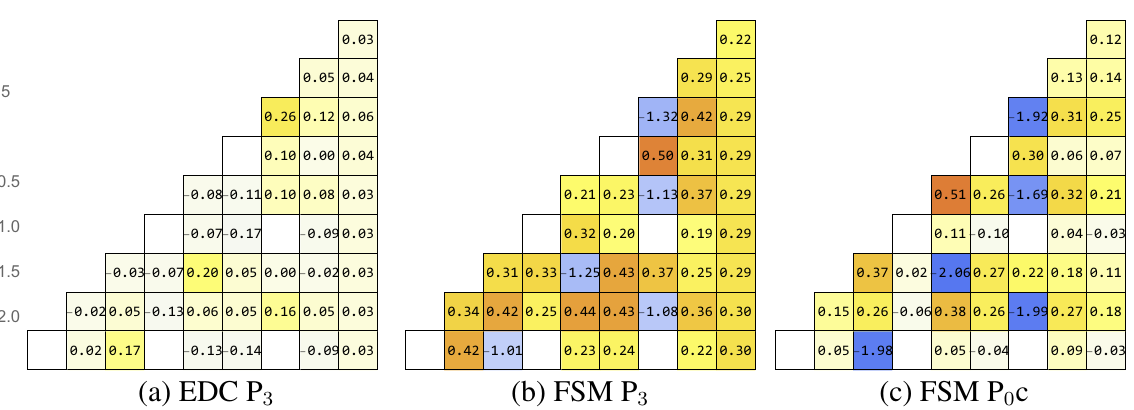
Figure 2: The pin-wise absorption rate percent errors in the Gd-UOX assembly